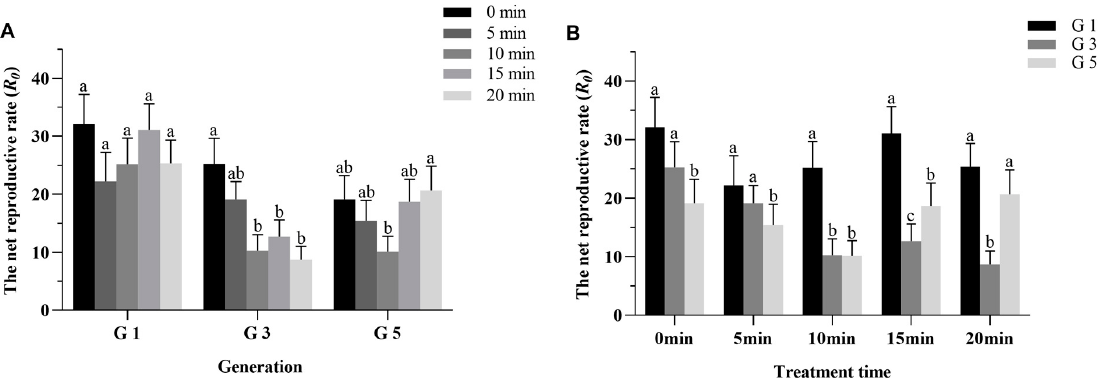
Figure 2. Net reproductive rate ( R 0 ) of the first, third, and fifth generations of P. xylostella under HVEF stress. Note: Values are expressed as mean ± standard error (SE). ( A ) The different lowercase letters indicates a significant difference at p < 0.05 between generations for groups exposed to electrostatic fields (0, 5, 10, 15, and 20 min). ( B ) The different lowercase letters indicates significant differences at p < 0.05 between treatments for 3 generations (G1, G3, and G5). Differences were compared using the paired bootstrap test.